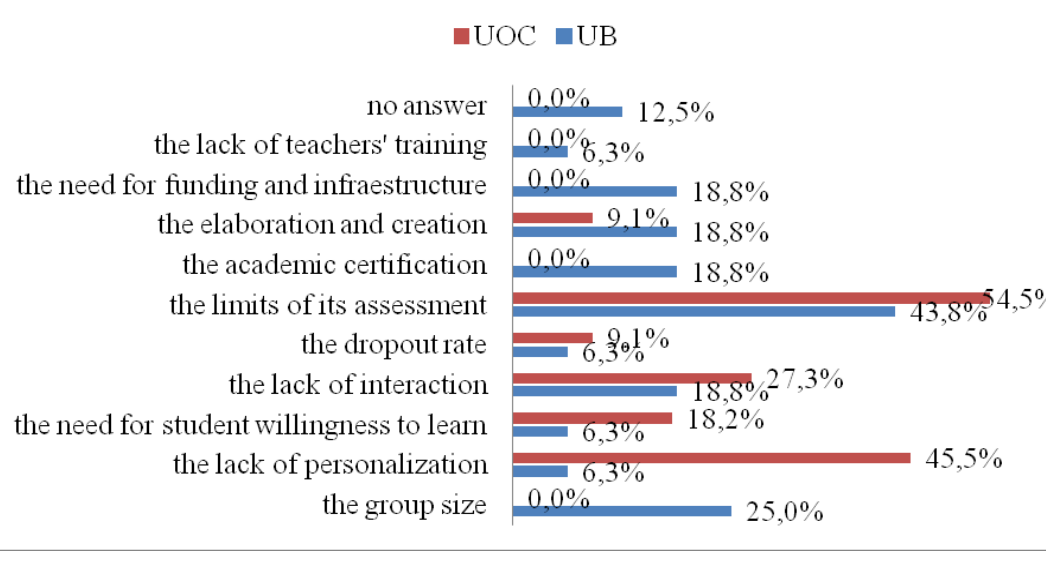
Figure 4. Comparison of the perceptions of teachers from both universities about the benefits of the new